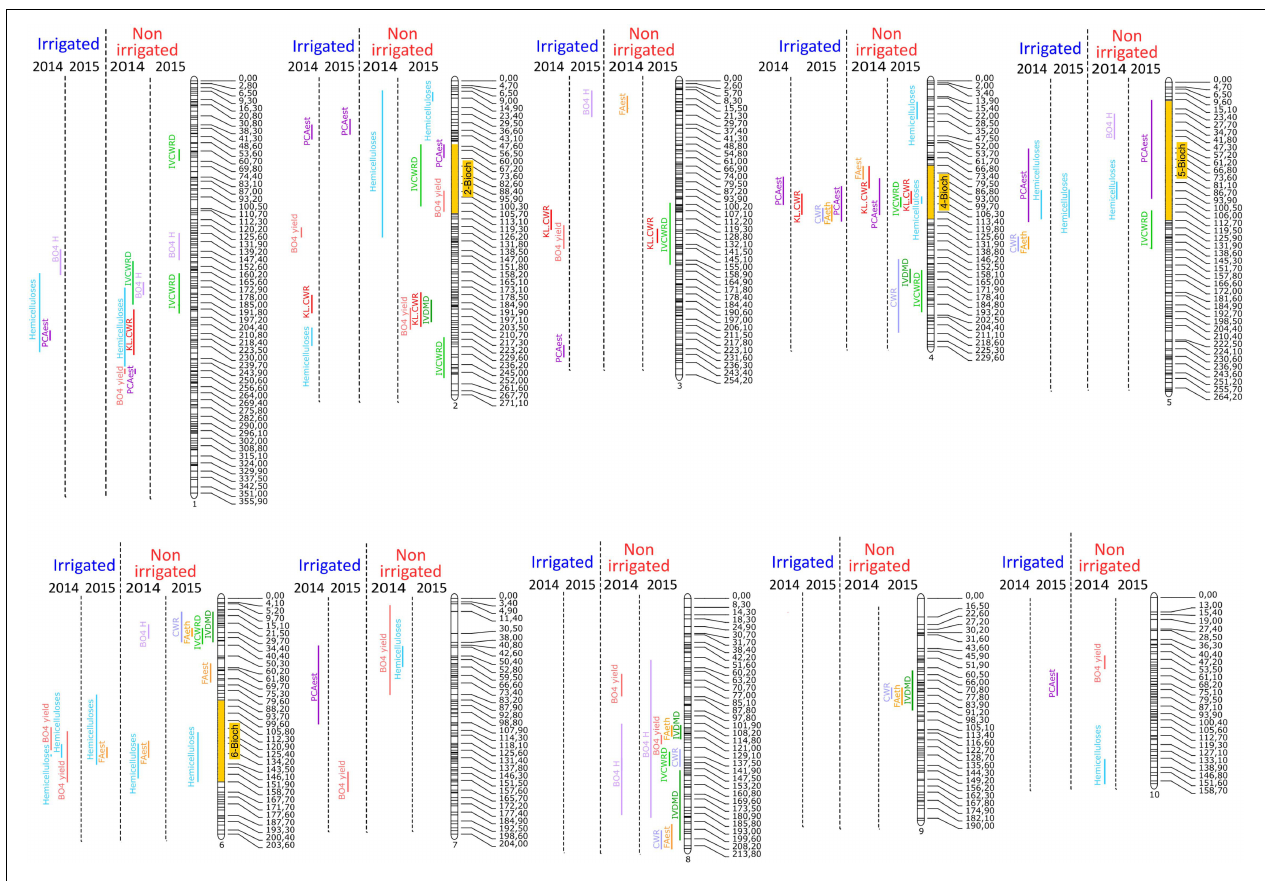
FIGURE 2 | Mapping of QTL involved in the variations of biochemical traits on the 10 chromosomes of maize genome for the four conditions: 2014 irrigated, 2015 irrigated, 2014 non-irrigated, and 2015 non-irrigated.